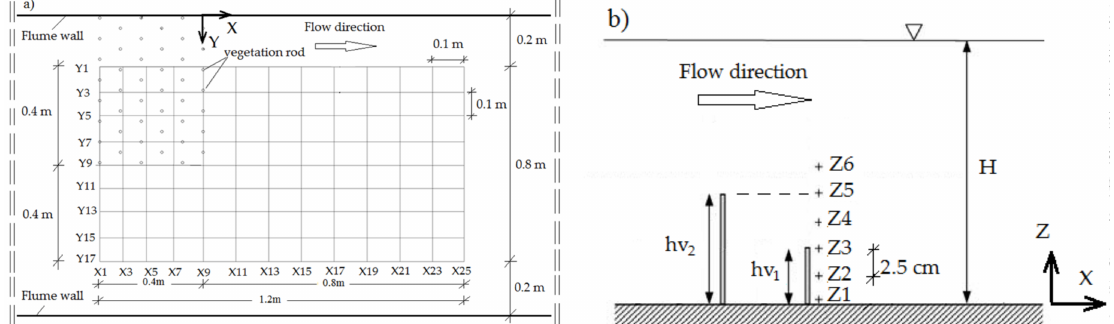
Figure 4. Velocity measurements grid: ( a ) Plan-view; ( b )